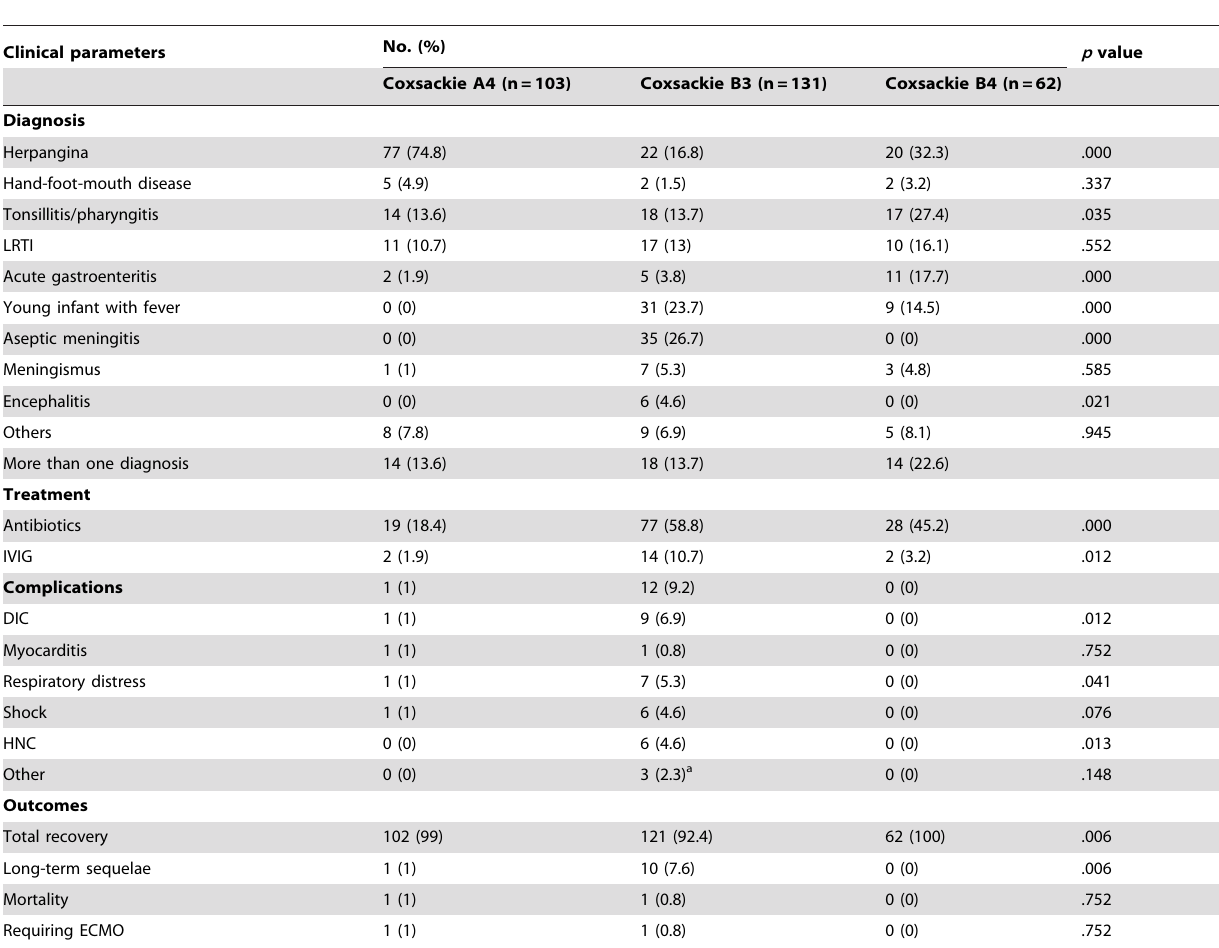
Table 4. Diagnosis, treatment, complications and outcomes of 296 hospitalized children with coxsackievirus A4, B3 and B4 infections stratified by